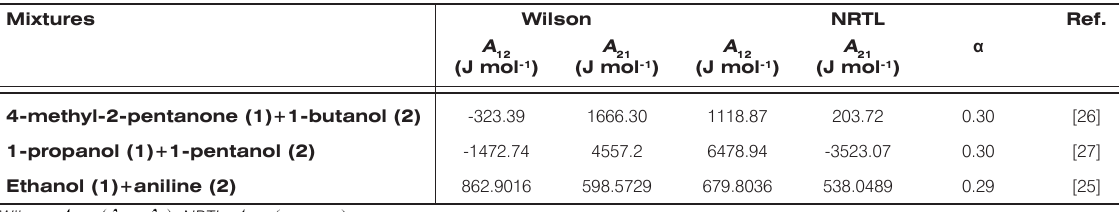
Table 2. VLE parameters of the Wilson and NRTL equations for the studied systems*. Mixtures